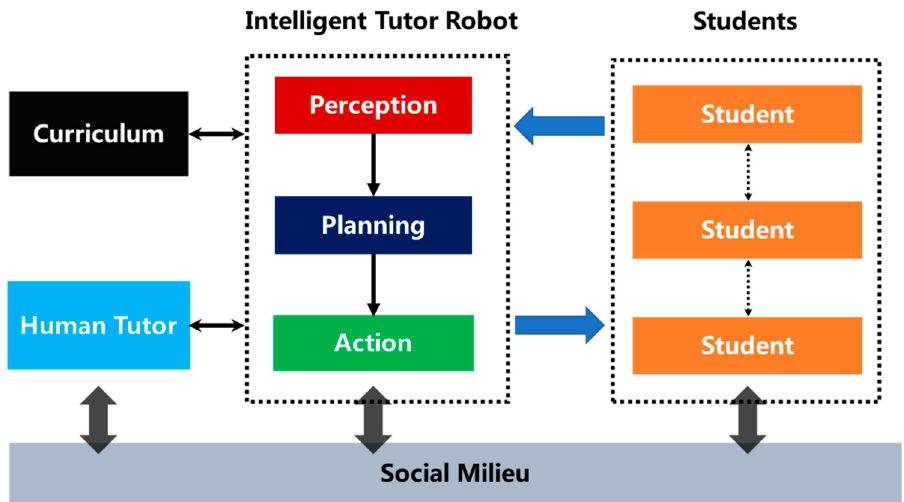
Figure 1. Perception-planning-action architecture of the intelligent tutor robot (ITR) and its interactions with the human-tutor, social milieu, curriculum, and students.